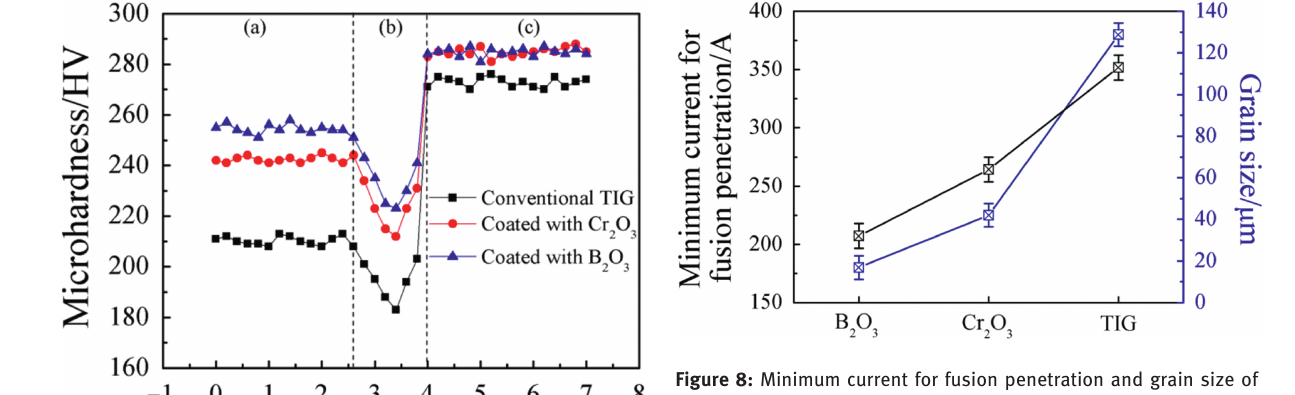
Figure 8: Minimum current for fusion penetration and grain size of the welding heat-affected